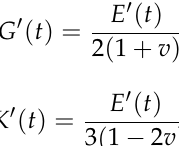
Coatings 2022 , 12 , x FOR PEER REVIEW Figure 7. The master curve of storage modulus for EMC sample. Figure 7. The master curve of storage modulus for EMC sample.